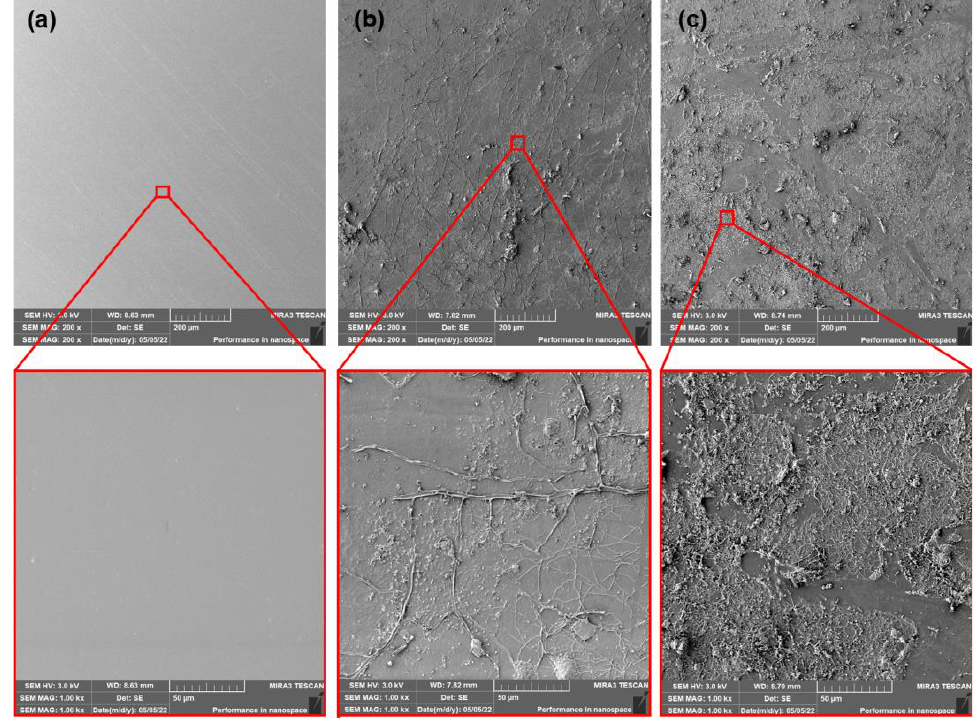
Figure 13. SEM images of aged PLA/MC2178 films ( a ) at initial state and after ( b ) 14 days of thermophilic composting, and ( c ) 28 days of thermophilic composting.